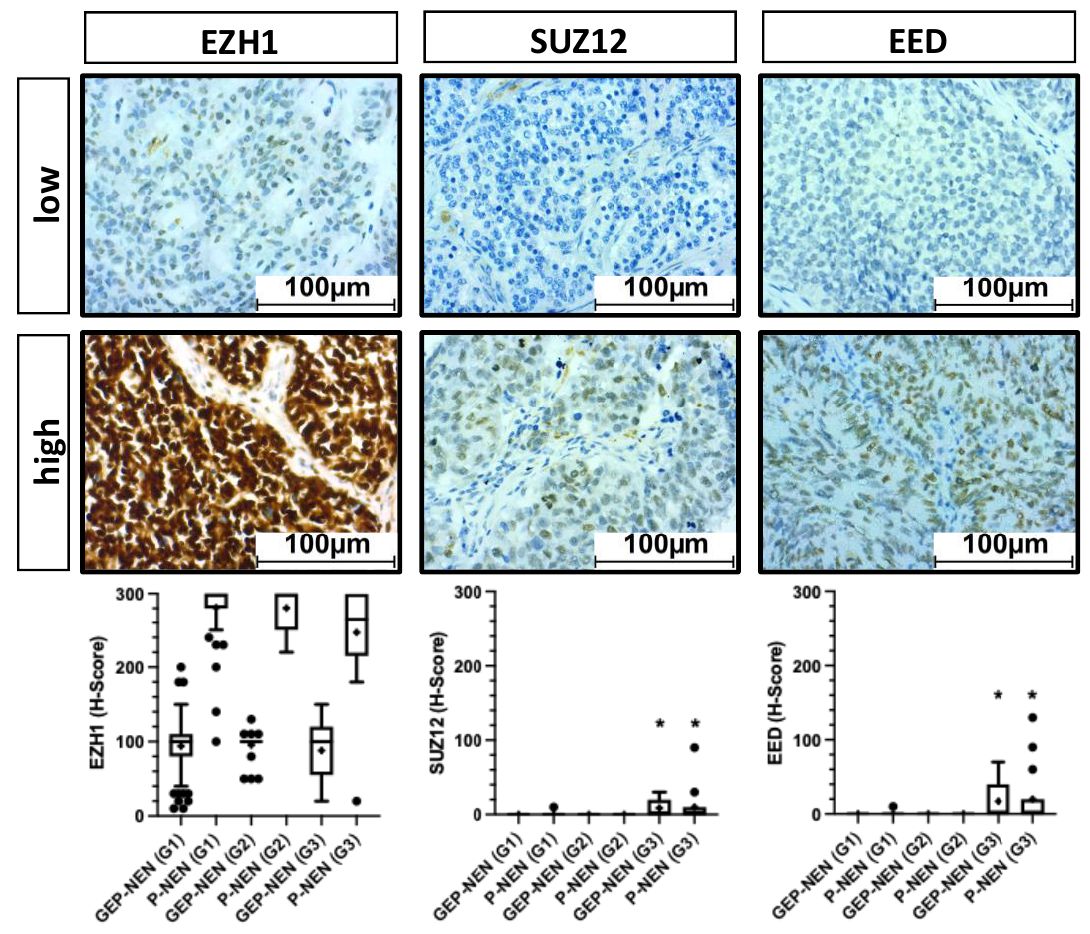
Figure 5. Expression of PRC2 members. Other members of the Polycomb Repressor Complex 2 (PRC2) were stained and quantified using the H-score. Expression was correlated with grading and entity (bottom line). The left column shows the results for EZH1, the middle column for SUZ12, and the right column for EED. EED: Embryonic Ectoderm Development, EZH1: Enhancer of Zeste Homolog 1, GEP: gastroenteropancreatic, NEN: neuroendocrine neoplasia, OS: overall survival, P: pulmonary, SUZ12: Suppressor of Zeste 12, *: significant compared to G1 and G2.